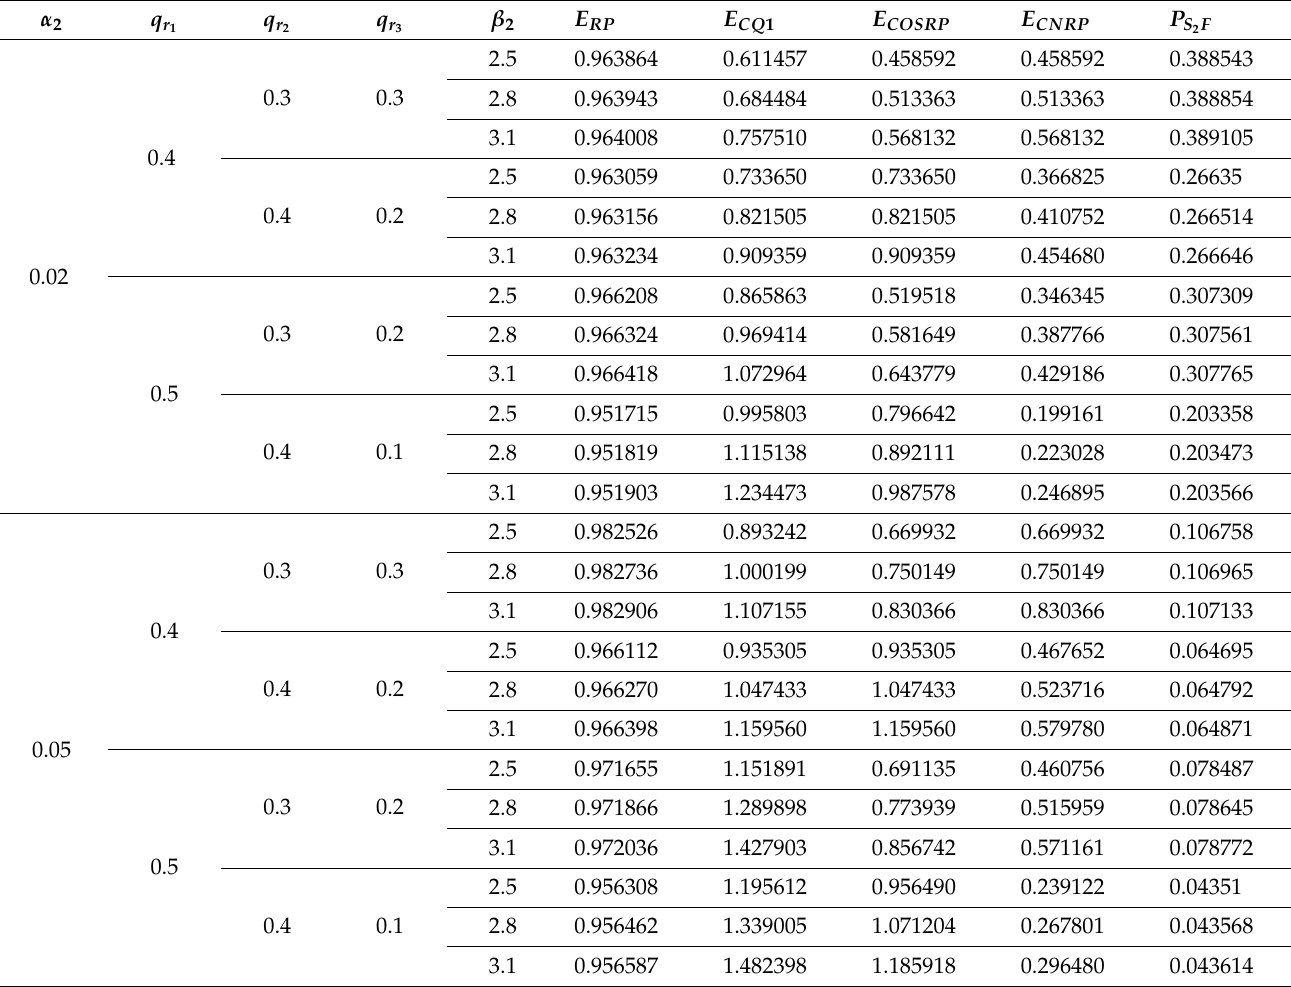
Table 1. Interpretation of parameters on